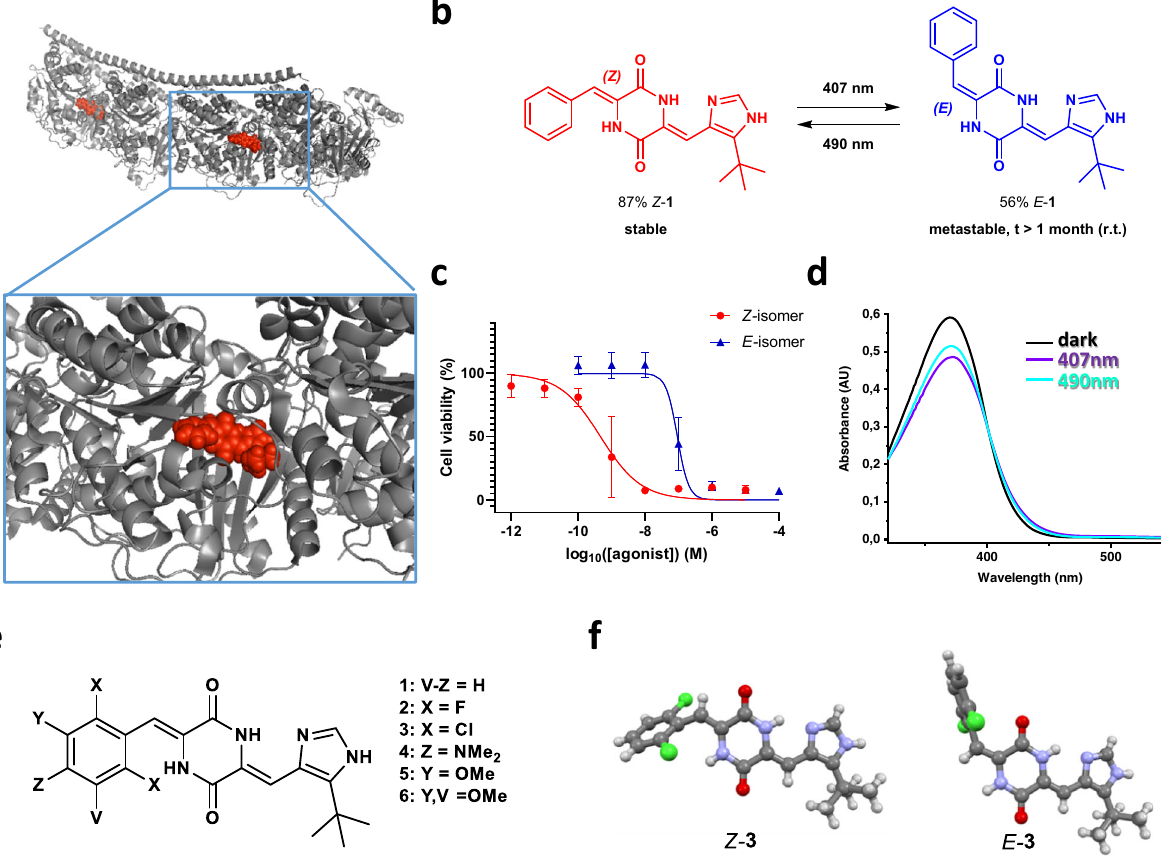
Fig. 1 | Plinabulin (1) and its derivatives as photopharmacological agents. a Z - 1 (red) binds β -tubulinin αβ -tubulinheterodimers (grey) (PDB:5c8y) 20 . b irradiationof the thermodynamically stable Z- 1 ( red ) with violet light (<410nm) produces up to 56% of the less active E- 1 ( blue ), which can be isolated and stored at ambient conditions for many days (t 1/2 >1 month); irradiation of E- 1 (blue) with cyan light (490nm) regenerates up to 87% of the active Z- 1 . c Viability of HT-29 cells after treatment with the HPLC-puri fi ed Z - and E -isomers of 1 for 48h. Data were plotted against the log of agonist concentration (log 10 ([agonist]) (M)) with mean and SD